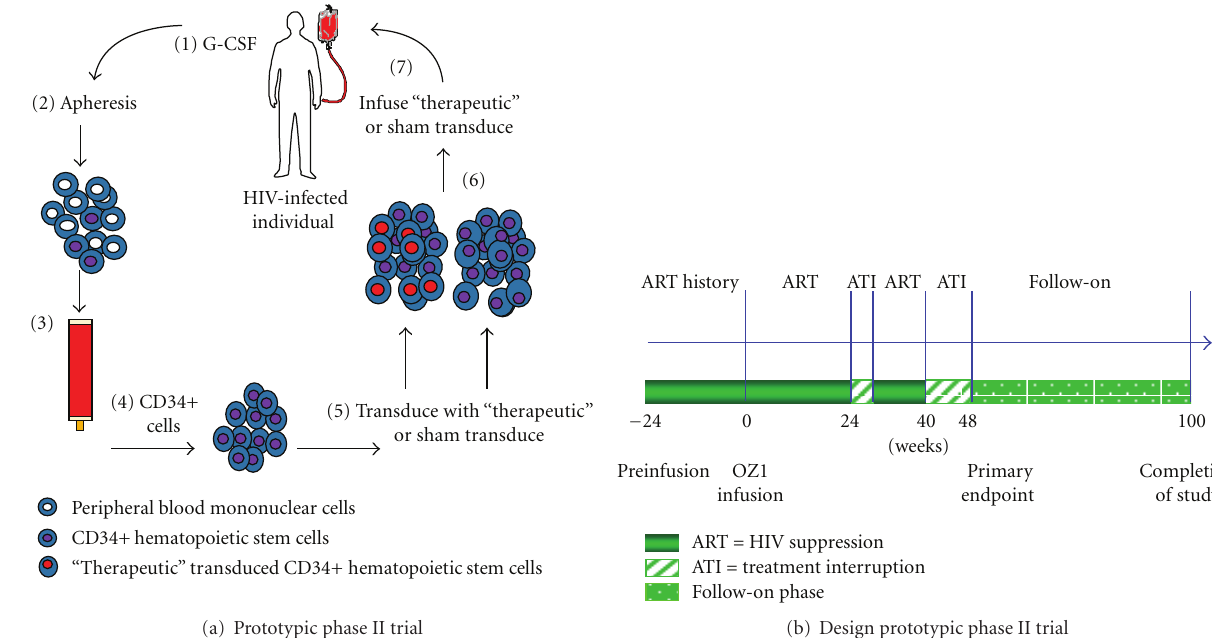
Figure 3: (a) The figure shows the prototypic phase II trial design in which CD34+ HSC are obtained from apheresis product that is CD34+ selected. The cells were then transduced with either sham (medium only) or OZ1-containing vector and that population (control or OZ1) infused into the individual. (1) Subjects are injected with a course of G-CSF to mobilize CD34+ HSC from the bone marrow to the peripheral blood. (2) Apheresis product is obtained. (3) The mononuclear cell fraction is applied to a CD34+ isolation system. (4) CD34+ cells are obtained. (5) These are sham transduced (medium alone) or transduced with OZ1 to obtain (6) a control population or OZ1 tranduced cells. (7) This population is infused back into the individual. (b) The figure shows the schedule for the phase II clinical trial. ART, antiretroviral therapy; ATI: analytic treatment interruption. The primary endpoint was viral load at weeks 47/48. Other end-points were area under the viral load curve weeks 40–48 and